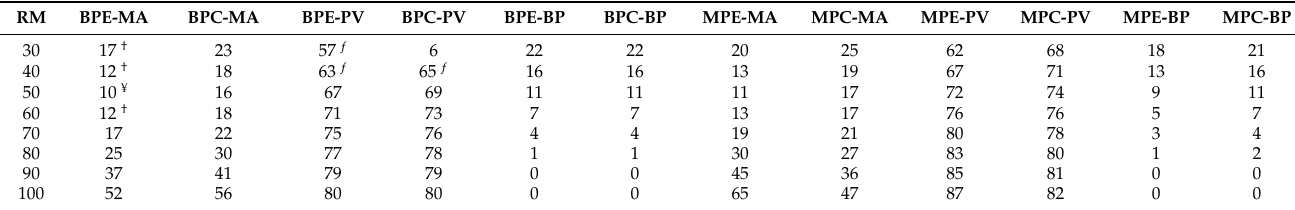
Data are presented as percentage (%). Abbreviations used: RM = maximum repetition; BPE = bench press eccentric/concentric; MA = peak acceleration; BPC = bench press concentric; PV = peak velocity; BP = braking phase; MPE = military press eccentric/concentric; MPC = military press concentric. † Significantly different from BPC-MA and MPC-MA ( p < 0.05). ¥ Significantly different from MPC-MA ( p < 0.05). ƒ Significantly different from MPC-PV ( p <